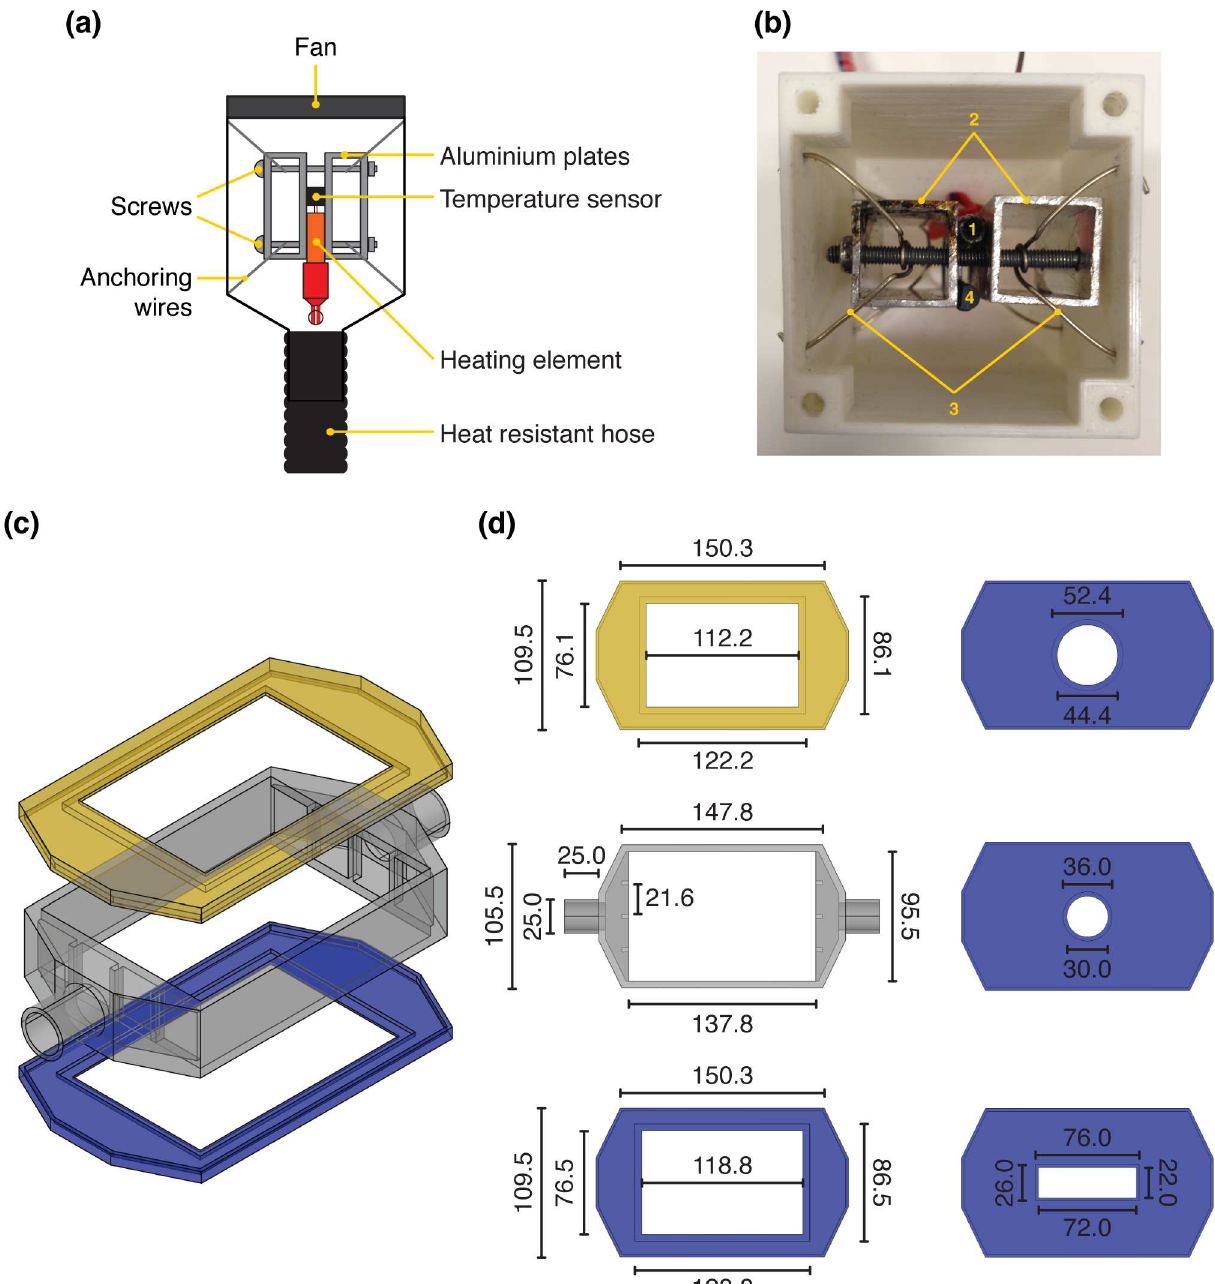
Fig 3. Heating unit and incubation module. (a) The heatingunit was constructed using a fan, a custom-built heatingcore, and a 3D-printed case designed to connect to the incubatorusing a heat-resistant hose. As a safety measure, a temperature sensor was placedclose to the heatingcore to monitor its temperature so that the heatingcould be turned off when the temperature exceededa preset safety limit. (b) Photograph of the heatingunit where the fan has been removedto show the position of the heatingelement(1), aluminumplates (2), the anchoring wires (3), and the limiting temperature sensor (4). (c) Explodedview of the onstageincubator. The 3D-printedincubatorwas built from three parts: a lid (yellow),a main body (gray), and a bottom plate (blue). Four different bottom plates were designed to fit the most common types of cell culture ware. (d) Main dimensions (in mm) of the incubatorlid and main body as well as for the different bottom plates designed to fit a multi-wellplate, a 60 mm Petri dish, a 35 mm Petri dish or a microscopeslide,